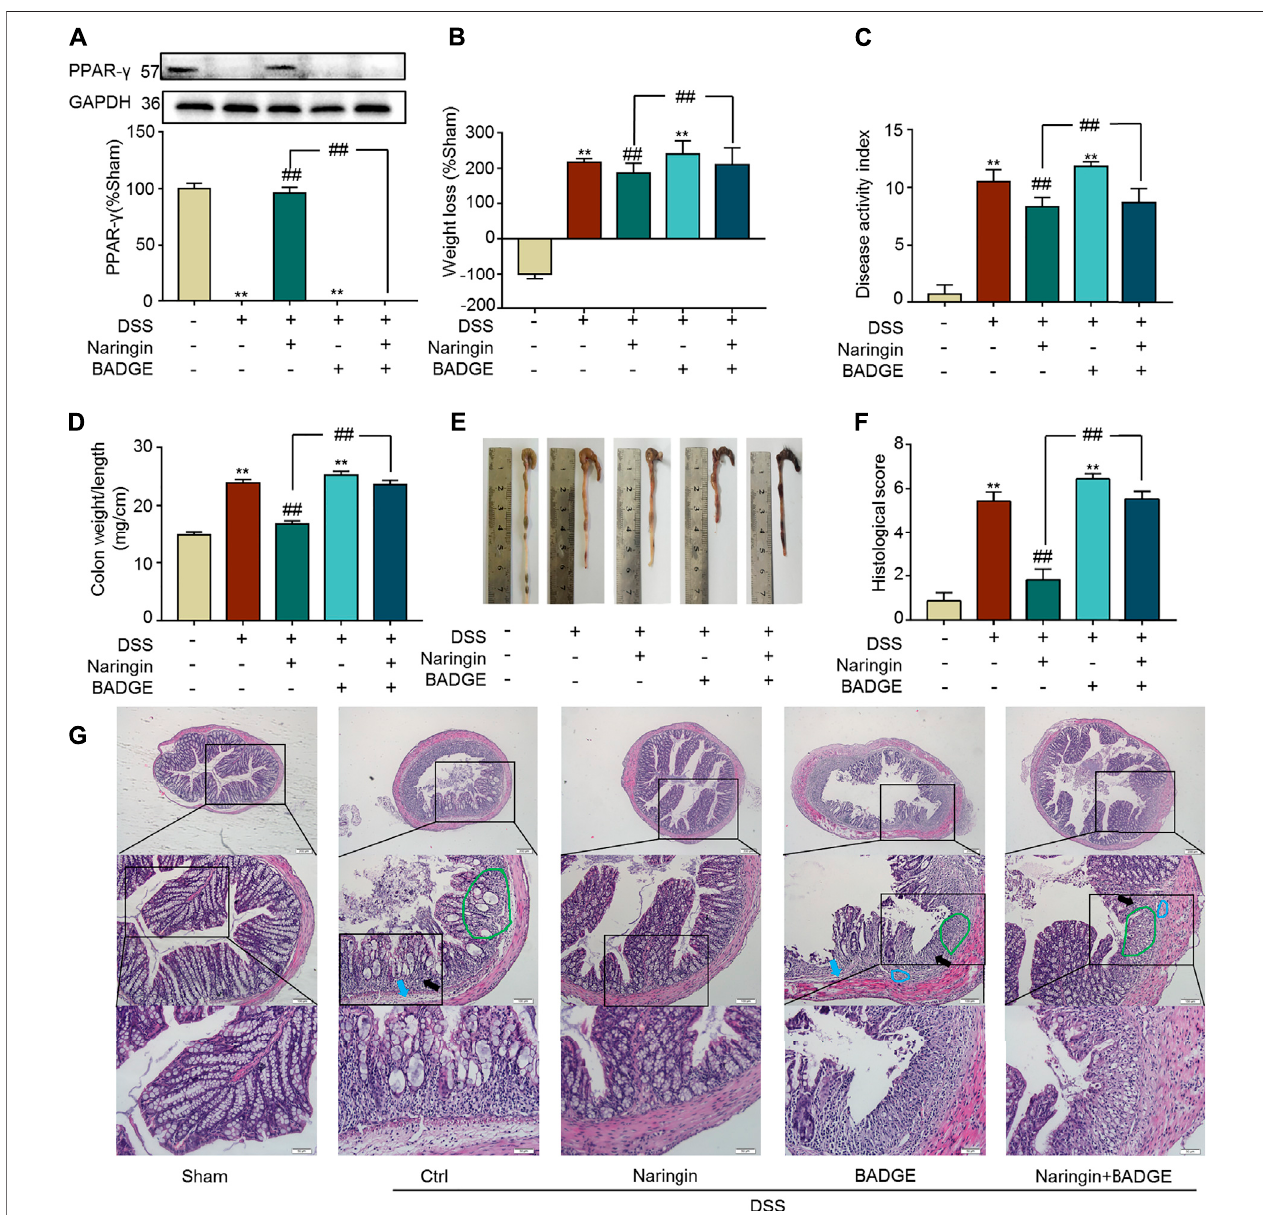
FIGURE 8 | Effects of PPAR- γ inhibitor BAGDE (30 mg/kg) on naringin induced treatment. (A) PPAR- γ expression in the presence of PPAR- γ inhibitor BAGDE. Effects of naringin (40 mg/kg) on (B) weight loss, (C) DAI, (D) colon weight-to-length ratio and (E) gross morphology of colon tissue. (F) Total histological score was calculated as the sum of epithelial damage and histological score. (G) H and E staining analysis of the aggravated symptoms with BADGE. Scale bars, 200, 100, and 50 μ m. Green ring indicates damaged villi structure; black arrow indicates in fi ltration of in fl ammatory cells; blue ring indicates submucosal edema, blue arrow indicates muscle fi ber separation. Data are expressed as mean ± SD. Values in the sham group are set to 100% and other values are given relative to those in the sham group. ** p < 0.01 compared with sham group; ## p < 0.01 compared with DSS-colitis group; n (cid:2) 3 samples in western blotting experiments; n (cid:2) 6 samples for other experiments. These blots are cropped, and the full-length blots are presented is in the Supplementary Figures S14 – S15 .